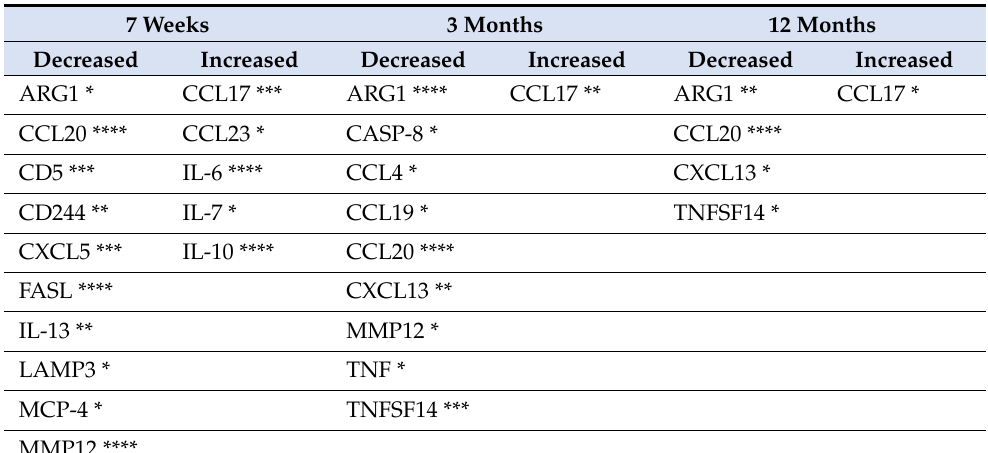
Table 1. Proteins that exhibited significantly increased or decreased expression at 7 weeks after the start of treatment, and at 3 months and 12 months after the termination of treatment, compared with baseline. 7 Weeks 3 Months 12 Months Decreased Increased Decreased Increased Decreased Increased ARG1 * CCL17 *** ARG1 **** CCL17